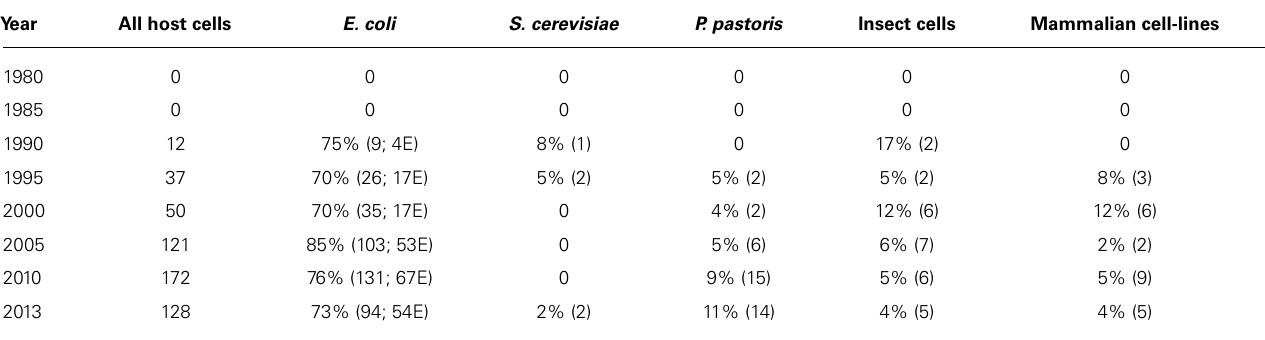
Table 1 | Recombinant gene expression in the most commonly used host cells.